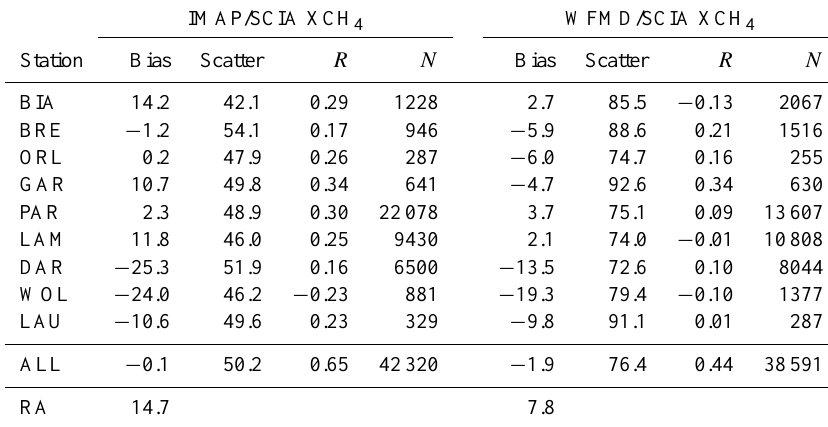
Table 7. IMAP and WFMD XCH 4 validation results for all individual stations and using all data combined (ALL). All results apart from R and N are in ppb